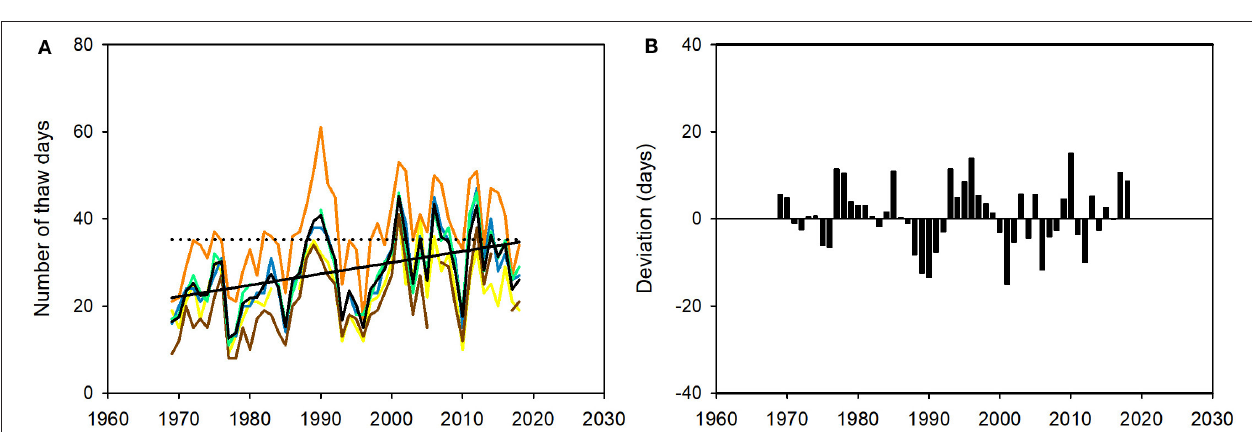
FIGURE 12 | The number of days in winter (October to April, O-A) on the reindeer winter pasture area of Finnmarksvidda ( Figure 7 ) with middle ambient temperature > 0 ◦ C (‘thaw days’), 1969–2018. Data from six weather stations: Cuovddatmohkki, Karasjok, Kautokeino, Sihccajavri, Skogfoss and Suolovuopmi ( Figure 7 ). (A) Annual mean value for all stations combined (black curve) and at each station (colored curves; days), and trend in numbers of days from a linear regression model O-A year thaw days = [(0.26 · year) – 491.45], r 2 = 0.22, p < 0.01 (straight black line). The dotted black line shows how the regression estimate for 2018 (35 days) was exceeded by the observed annual average in only 15.2% ( n = 5) of years before 2001 but in 47.1% ( n = 8) of years after 2001. (B) Annual deviations from the linear models (days). For color codes, see Figure 9 .